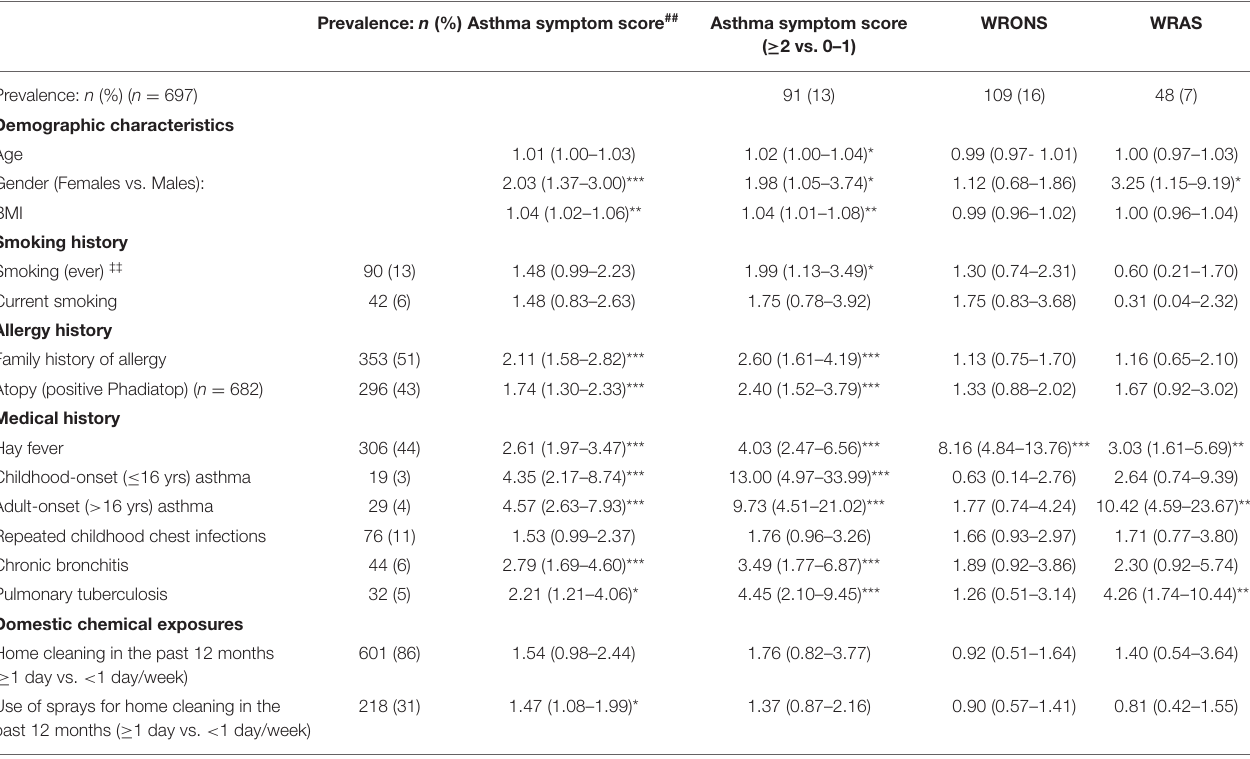
TABLE 4 | Host risk factors associated with respiratory symptoms among health workers working with cleaning agents. Prevalence: n (%) Asthma symptom score